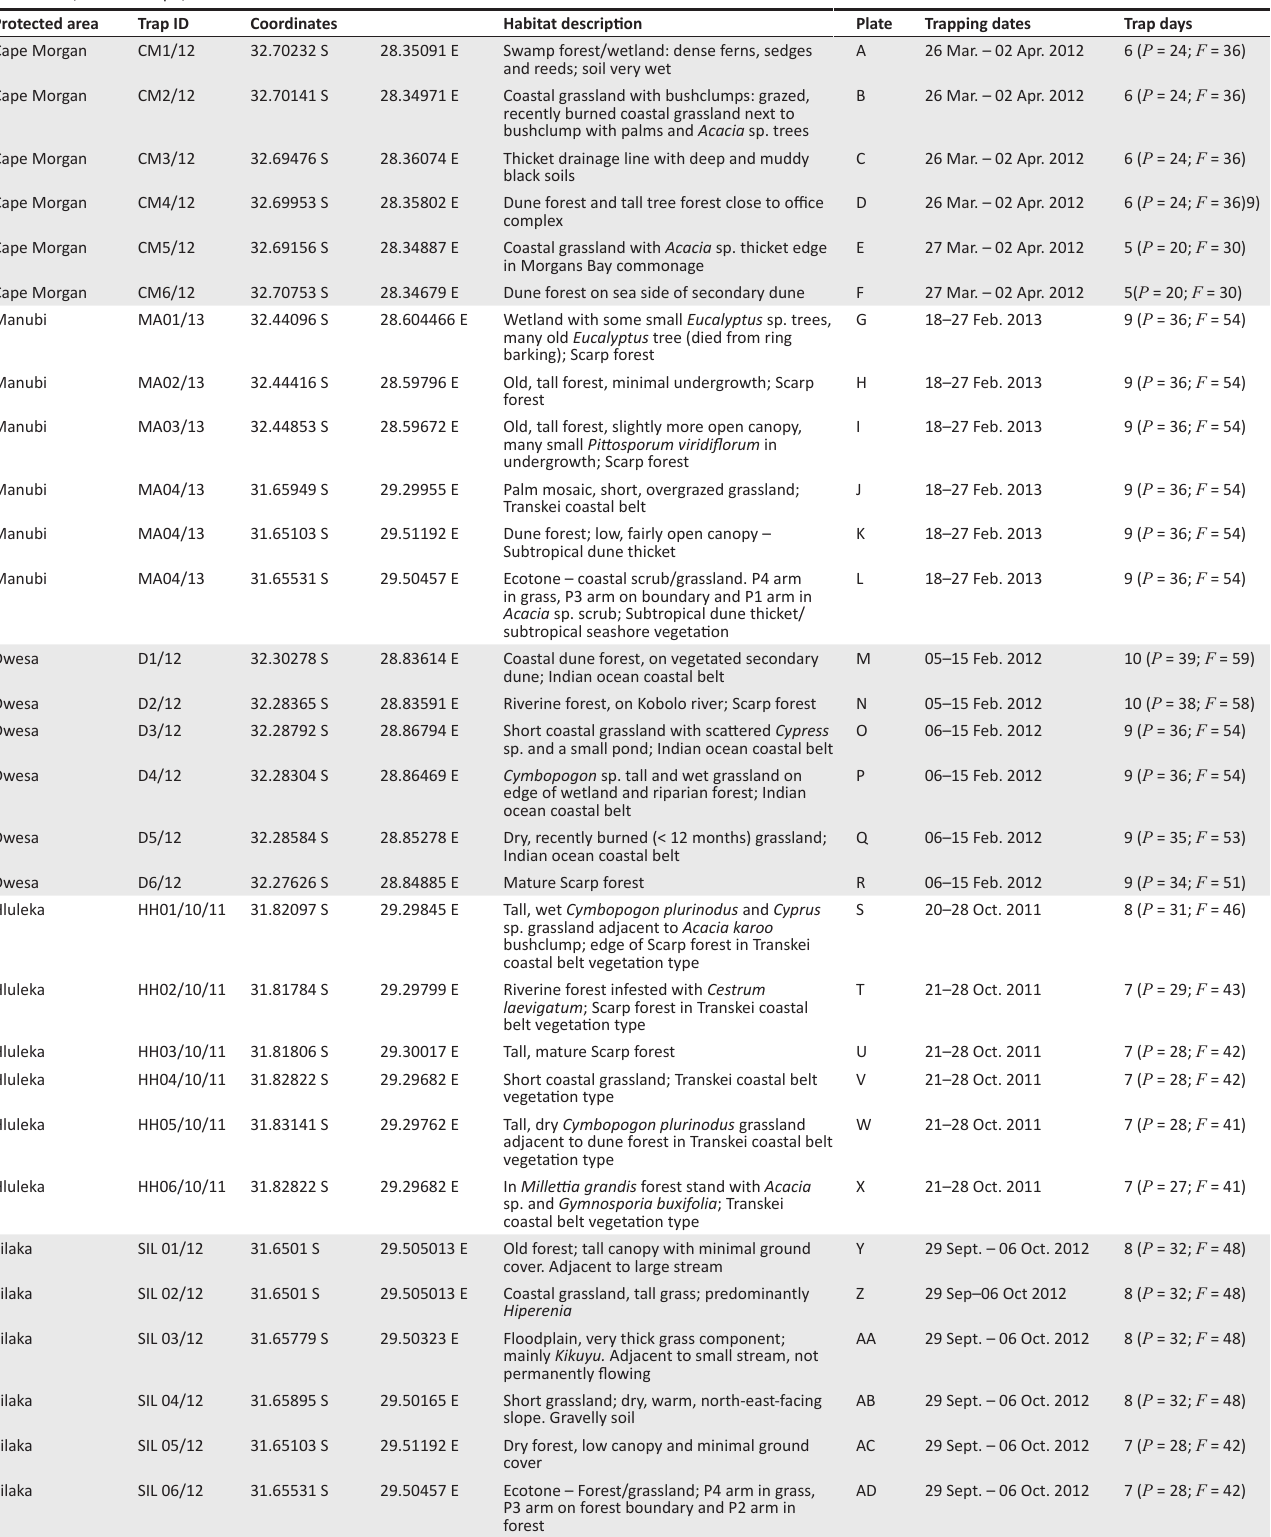
TABLE 1-A4: A summary of the locations, habitats and trapping dates where drift fence with pitfall or funnel combinations were set in the six protected areas along the Wild Coast, Eastern Cape, South Africa. Protected area Trap ID